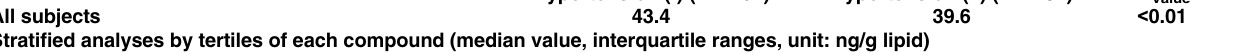
Table 2. Adjusted * means of Digit Symbol Substitution Test score among all subjects or stratified by tertiles of serum concentrations of organo- chlorine